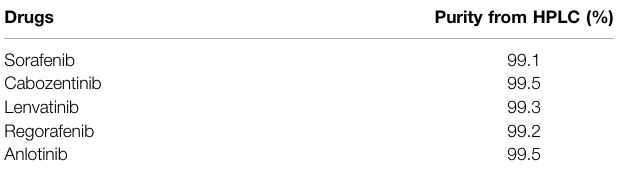
TABLE 1 | The purity of drugs used in the presence work from HPLC.